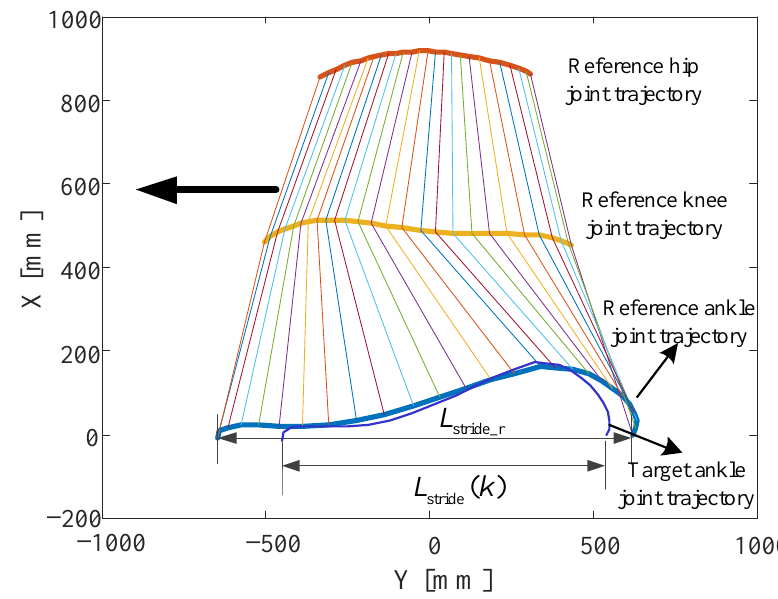
Figure 7. Resultant reference trajectories in Cartesian space and an example of a target ankle joint trajectory. Lower limb sizes are L 1 = 490 mm, L 2 = 430 mm, and L stride _ r = 1290.52 mm is the resultant stride length with the reference gait.